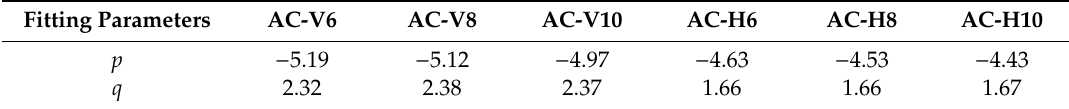
Table 2. Fitting parameters for the relationship between acceleration responses and wind velocities.